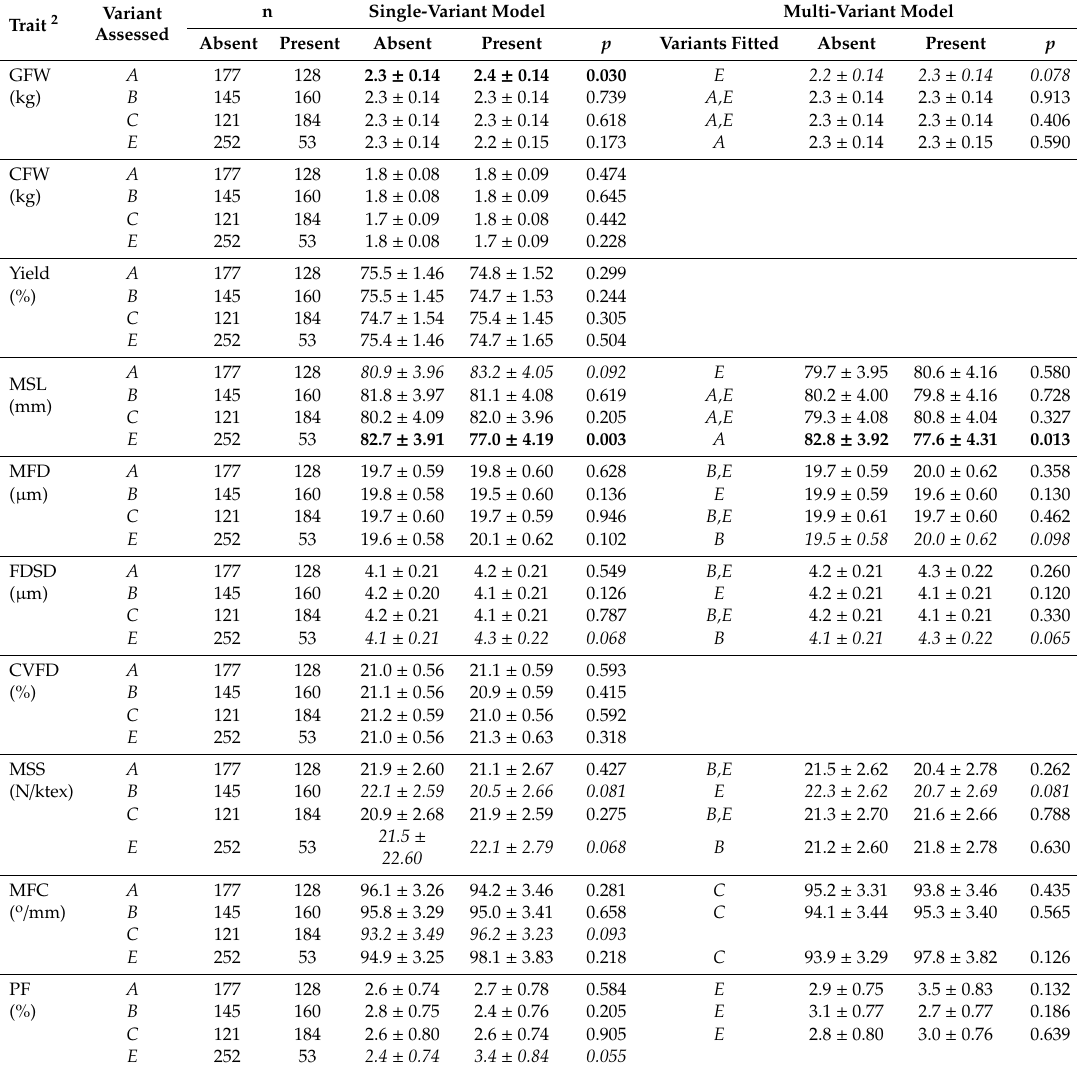
Table 2. Association between the absence or presence of KRTAP21-2 variants and various wool traits (Mean ± SE) 1